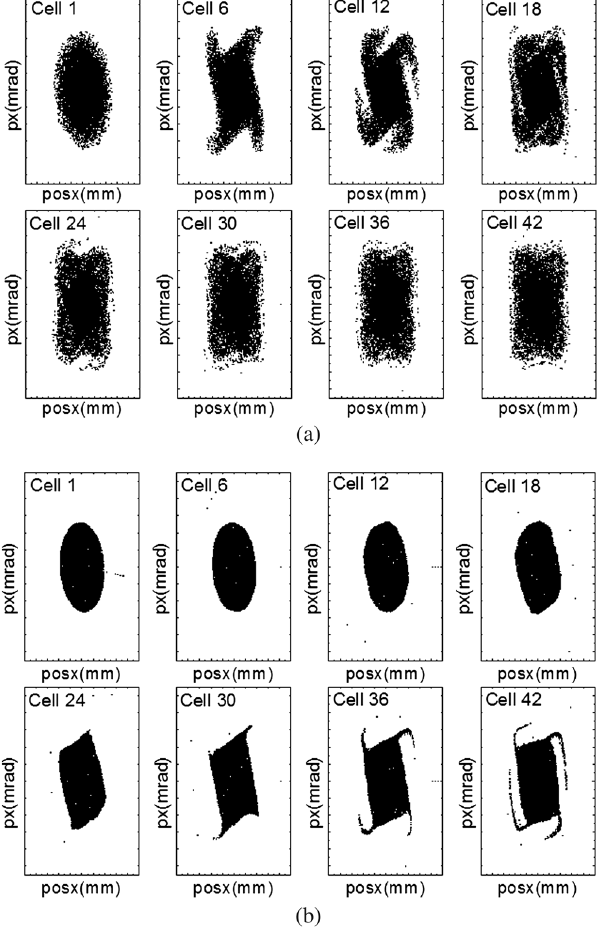
FIG. 6. Beam profile evolution in x - px phase space for σ i ¼ 87 , η ¼ 0 . 8 , with (a) parabolic and (b) KV initial distribution. The i axis scale is ( − 5 to 5 cm) in the pos x direction and ( − 125 to 125 mrad) in the px